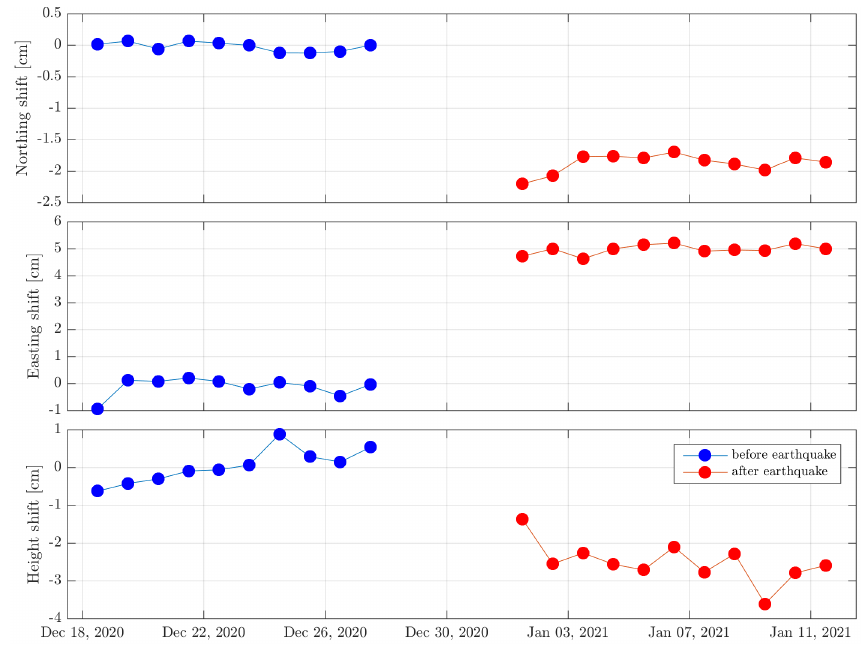
Figure 11. The graph shows positional (Northing and Easting) and vertical (Height) displacement of a GNSS CORS CROPOS station SISA located 30 km from the epicenter. Blue color represents the state before the earthquake and red color after the